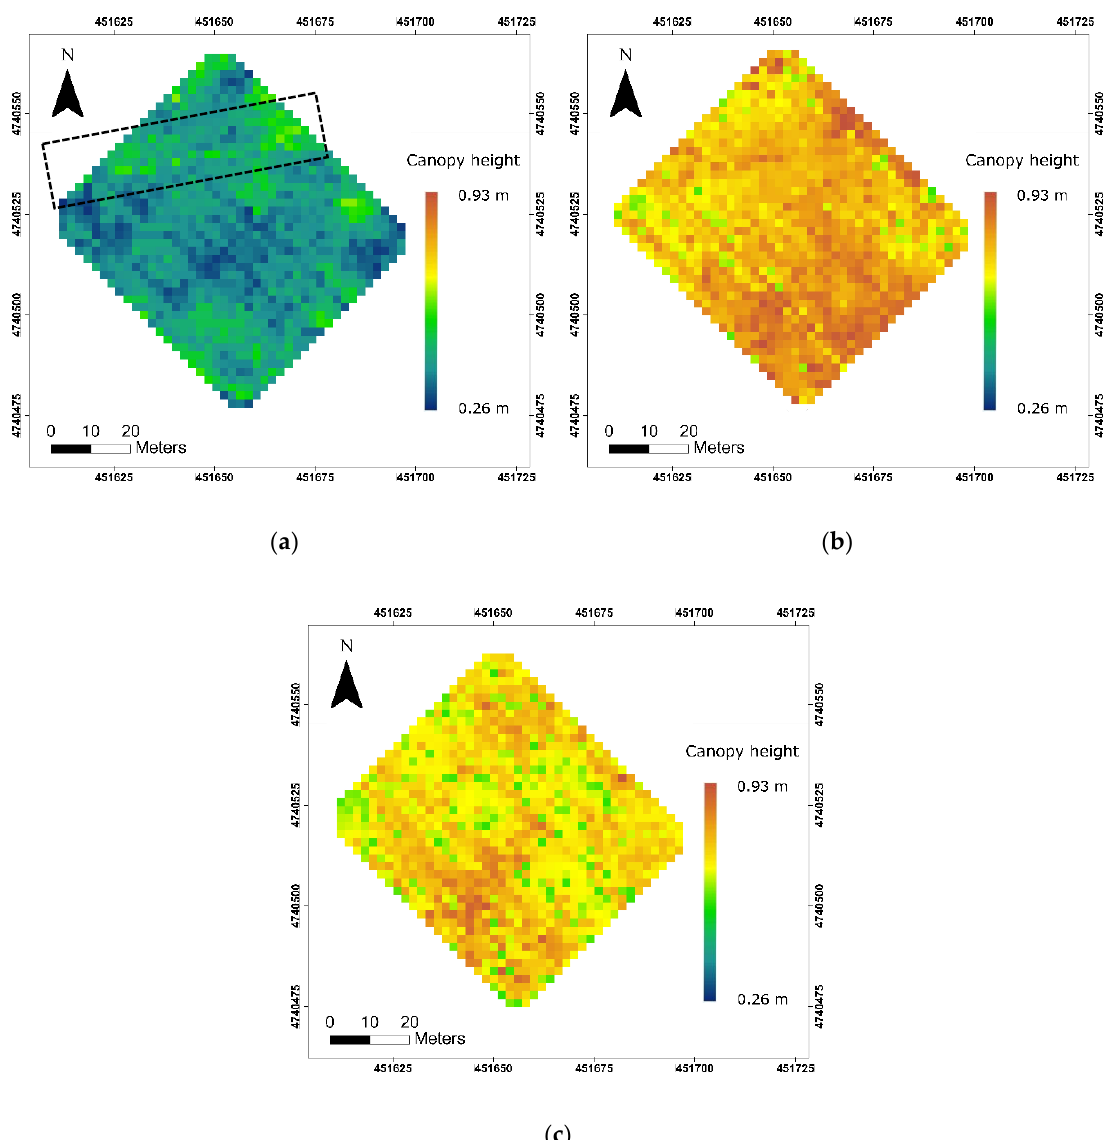
Figure 10. The final maps of canopy height in the study area at di ff erent growing stages. ( a ) 16 May; ( b ) 31 May; ( c ) 9 June. After removal of the unsolved pixels, the final map was generated using the inverse distance weighted (IDW) interpretation method and displayed as cubic convolution resampling. The black dash rectangle showed an area with a higher height estimation on the crop height map.